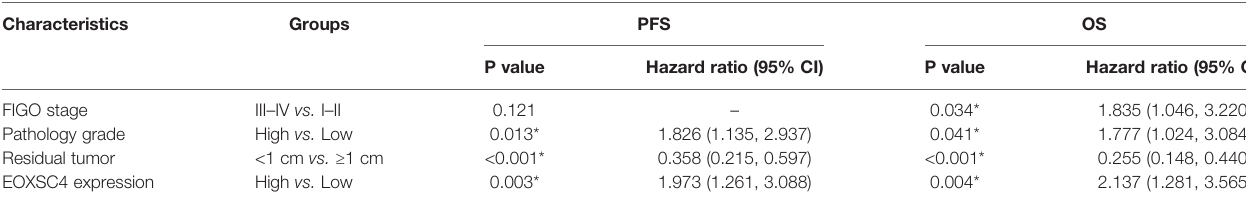
TABLE 4 | Multivariate analysis of factors predicting PFS and OS.